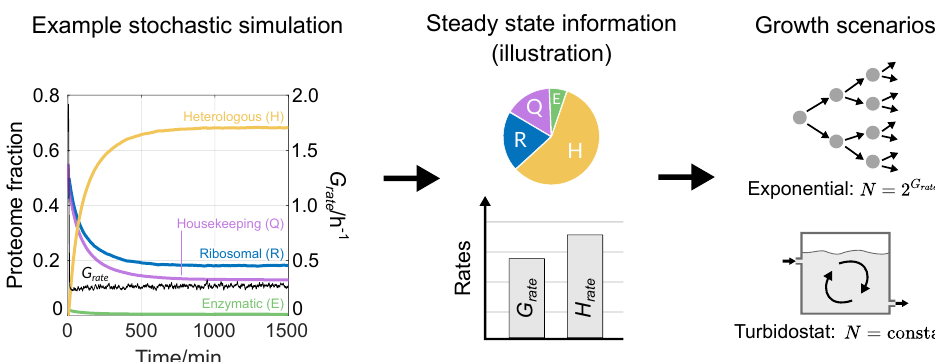
Figure 3. How we apply StoCellAtor to relevant growth scenarios. ( Left ) An example stochas- tic simulation of the different proteome fractions (left y-axis) and growth rate (right y-axis) with = 3 and RBS = 1. Values start out of equilibrium, go through transient dynamics and prom H H finally reach steady-state values. ( Middle ) An illustration of the steady-state information gained from each simulation. ( Right ) Steady-state information is used to assess protein production in a hypothetical population that grows over time. Two growth scenarios are considered: uncapped exponential growth and growth within a